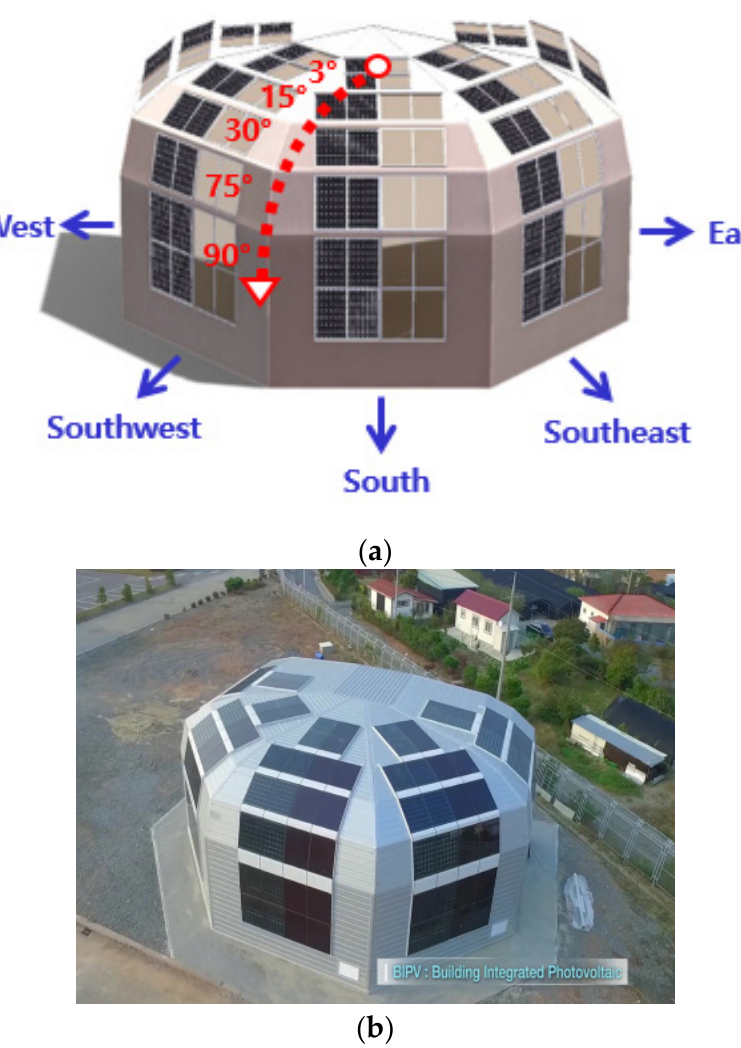
Figure 2. Two views of the constructed mock-up test building: ( a ) Model view; ( b ) Aerial photo.